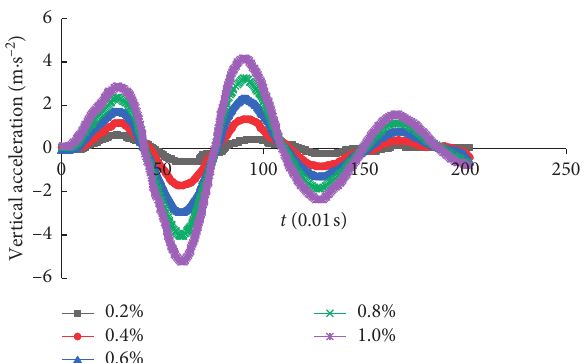
Figure 13: Vertical acceleration of testing vehicle at different longitudinal slopes.